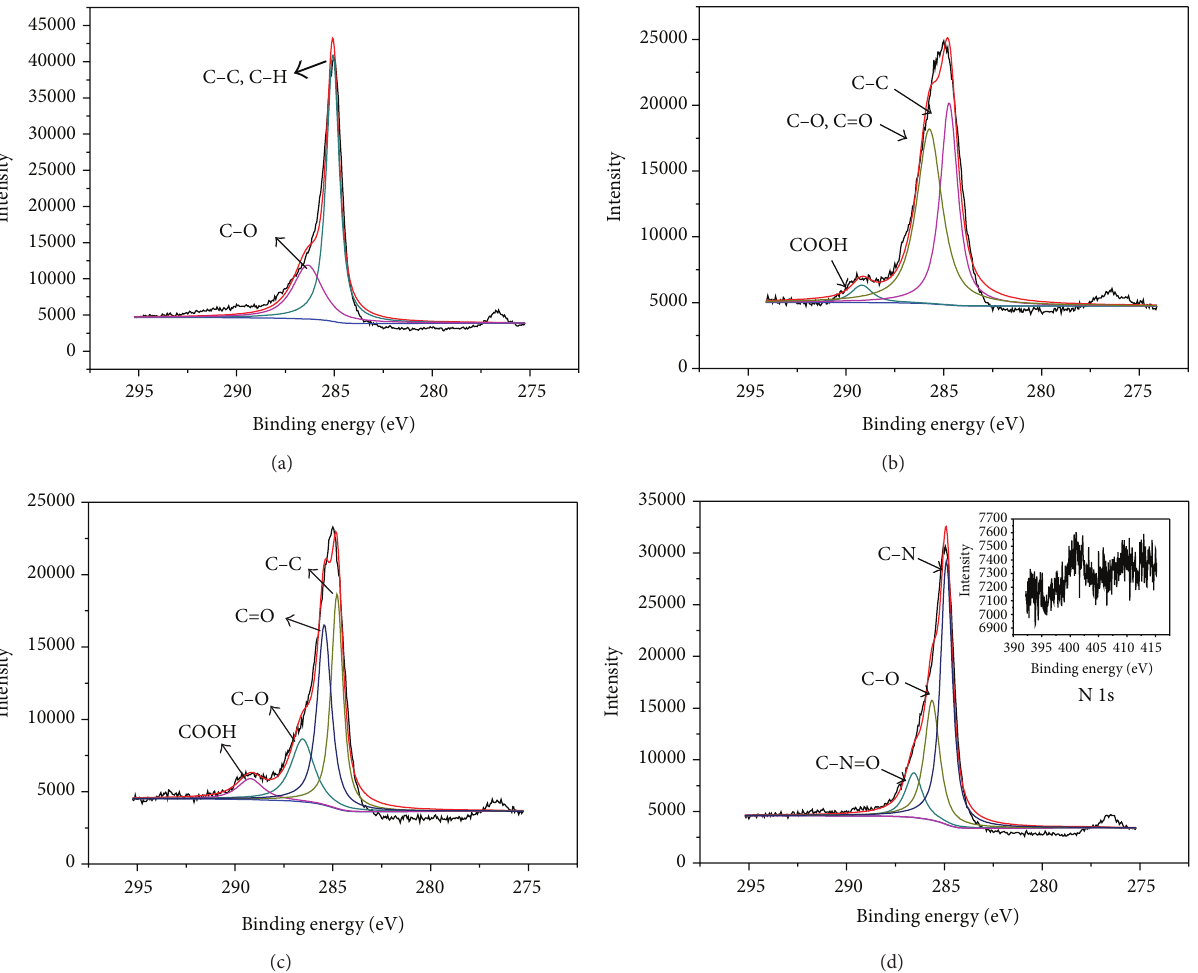
Figure 8: XPS spectra of the C 1s of the carbon plate as model electrode (a), MWNT-modified electrode (b), COOH/MWNT-modified electrode (c), and AChE-ChOx/COOH/MWNT-modified electrode